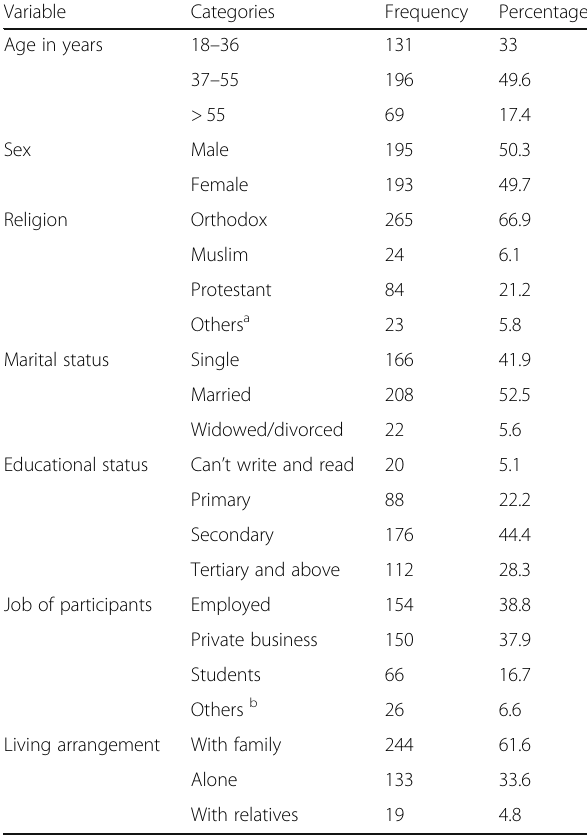
Table 1 Socio-demographic characteristics of people with HIV/ AIDS attending ART follow-up at Zewditu Memorial